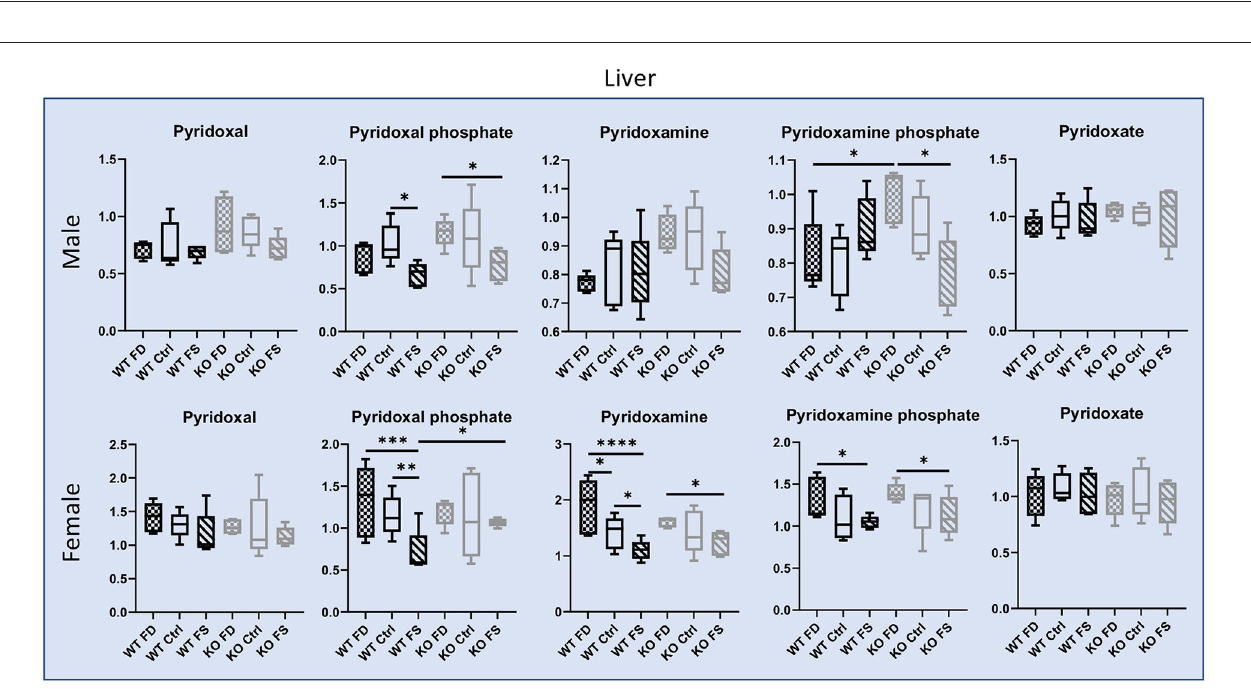
FIGURE 6 | B 5 metabolites in male (A) brain and (B) testes show fewer differences between genotypes or dietary FA. In females, most pantothenate metabolites showed FA dose-dependent trend for KO, but not WT mice. Data are shown with minimum and maximum and a bar at median value, n = 5. Checked bars, FD diet; solid bars, Ctrl diet; striped bars, FS diet. WT is shown in black, and KO is shown in gray. * p < 0.05; ** p < 0.01; *** p < 0.001; determined by ANOVA comparisons.